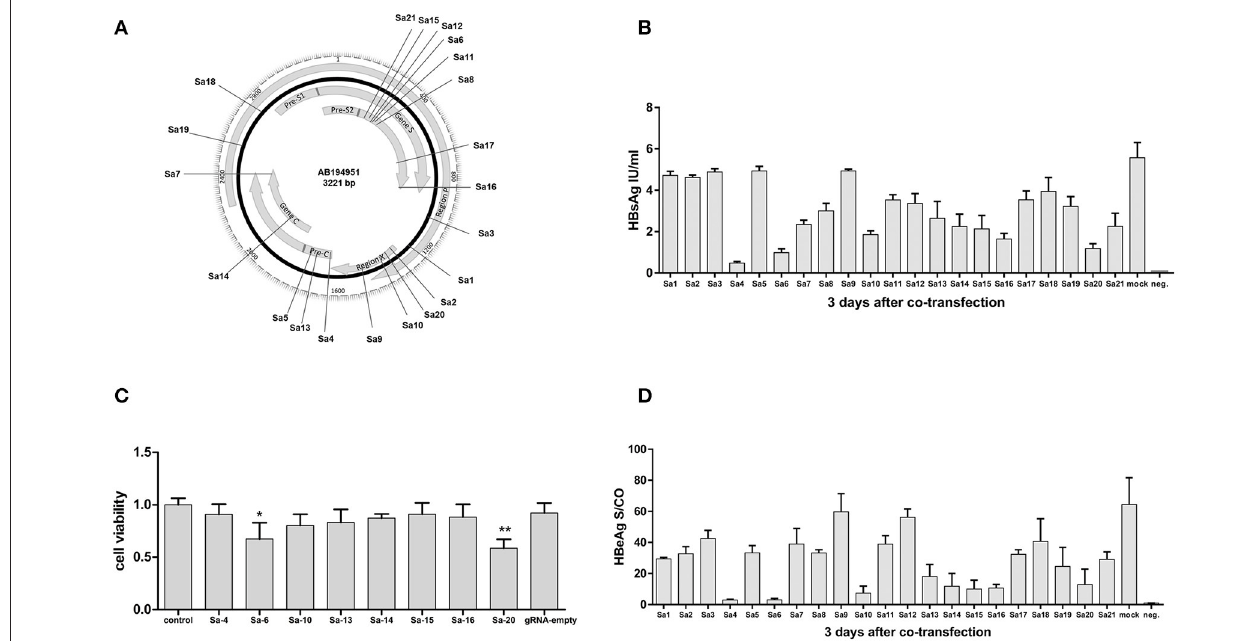
FIGURE 1 | Identification of an effective HBV-specific CRISPR/SaCas9 system. (A) Illustration of gRNA-targeted sequences located in the HBV genome. (B) Results of HBsAg measurement in cell-culture supernatants on the 3rd day after co-transfection with CRISPR-SaCas9 and pGL3-HBV1.2 expression vector in 293T cells. Error bars, SD; n = 3. (C) CCK-8 assay performed at the indicated time points after transfection (absorbance at 450nm, A450). (D) Level of HBeAg in cell-culture supernatants on the 3rd day after co-transfection with CRISPR-SaCas9 and pGL3-HBV1.2 in 293T cells. Error bars, SD; n =